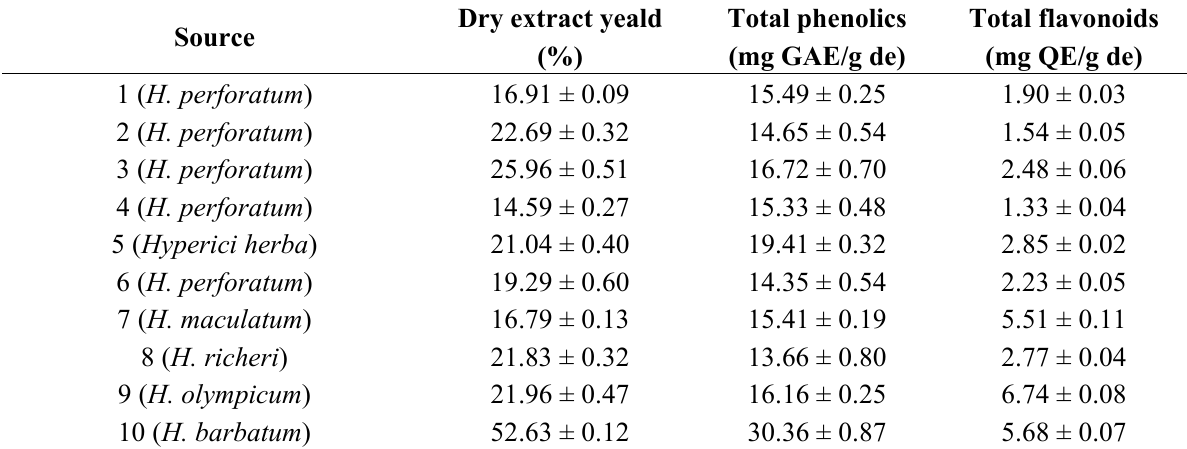
Table 1. Content of dry extract (g/100g of crude drug), total phenolics (mg GAE/g de) and total flavonoids (mg QE/g de) in the extracts of investigated species of Hypericum